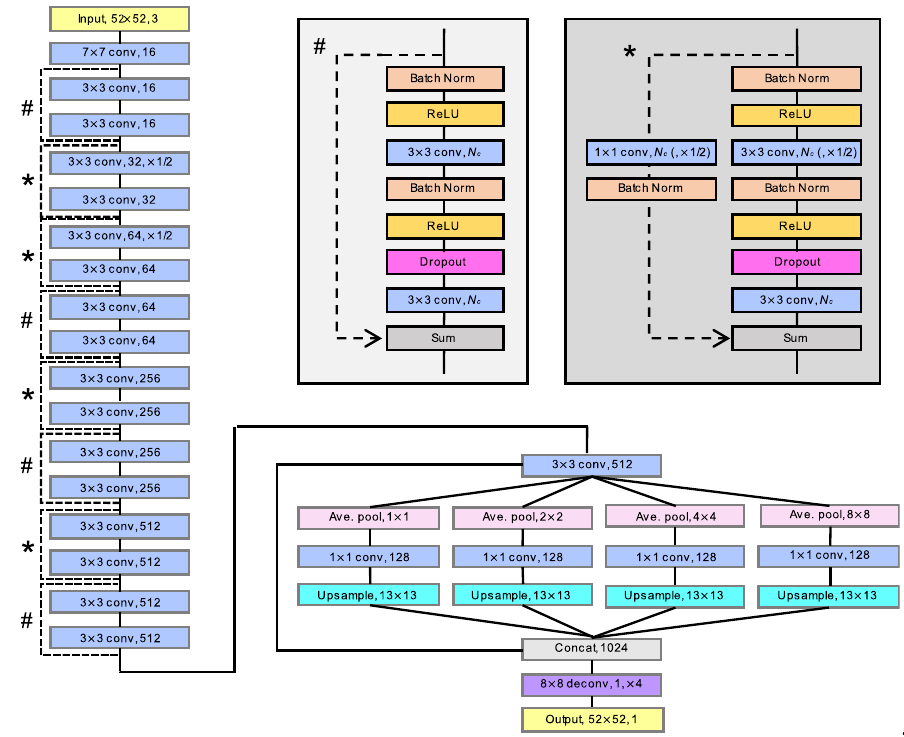
Figure 4. Structure of a simplified version of a convolutional neural network (CNN) used for a test of COT estimation based on the zenith-viewing transmitted radiances. The input and output layers (yellow) are presented with the image size (in pixels) and the number of channels / variables. The input takes a multispectral image with three spectral channels, and the output is a two-dimensional distribution of COT. The neural network (NN) layers denoted in light blue and purple represent the convolutional and deconvolutional layers, respectively, shown with a filter size and the number of output channels. The “ × 1 / 2” represents the convolution to halve the size of the feature map. The NN layers denoted in pink represent the average pooling to obtain a feature map with a shown number of pixels. In the “upsample” layer, bilinear interpolation is performed to expand the feature map, in order to obtain the shown number of pixels. The “concat” layer concatenates all of the channels in the layer input. The layer blocks denoted by black dashed lines with marks (# and *) are the residual blocks with detailed structures, shown separately in the upper right. These consist of batch normalization (“batch norm”); a rectified linear (ReLU) activation function; and convolution with a 3 × 3 filter, dropout, and summation (“sum”) operators. More details are explained in the main text.